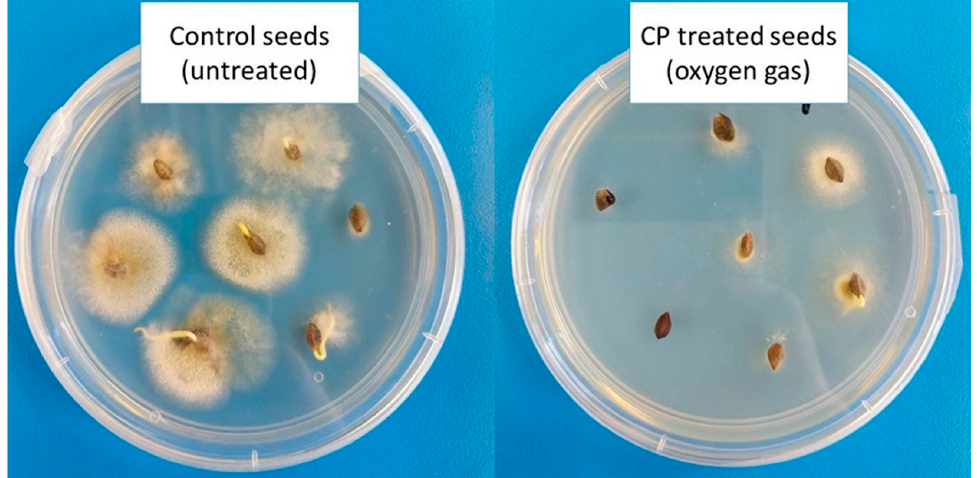
Figure 2. Decontamination of naturally occurring fungi on common buckwheat seeds ( Fagopyrum esculentum Moench) using radio-frequency-generated LP oxygen CP. Fungal growth after 1 week of cultivation on PDA growth medium is shown [33].